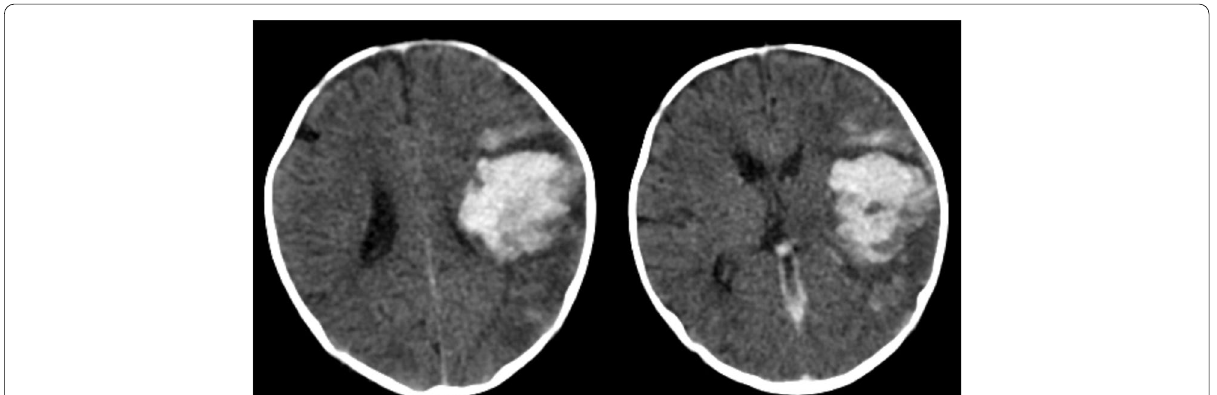
Fig. 3 Brain CT of case 2. Large left hemispheric intraparenchymal hematoma, with perilesional edema that conditions a mass effect, compressing on the lateral ventricle on the same side, with a centered midline. Subarachnoid hemorrhage. No opening of bleeding to ventricles. Nondilated ventricular size